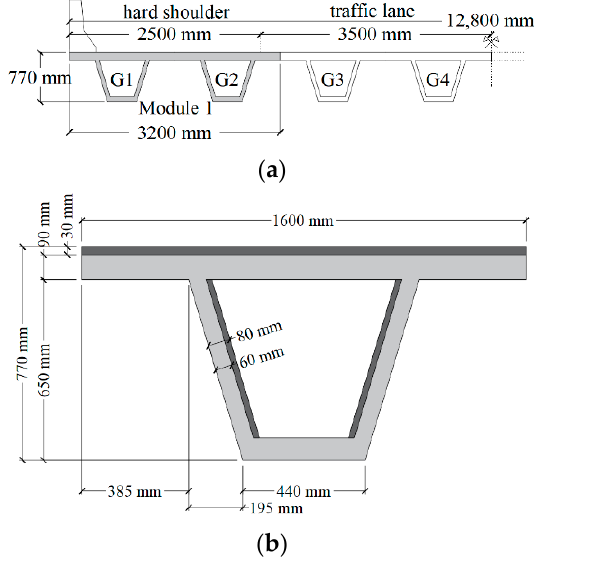
Figure 1. Full-scale prototype of a box girder of an R/SFRC bridge [44]: ( a ) bridge cross-section formed by modules composed of two box girders; ( b ) dimensions of the cross-section of a box girder; ( c ) the box girder prototype during the removal of formwork.